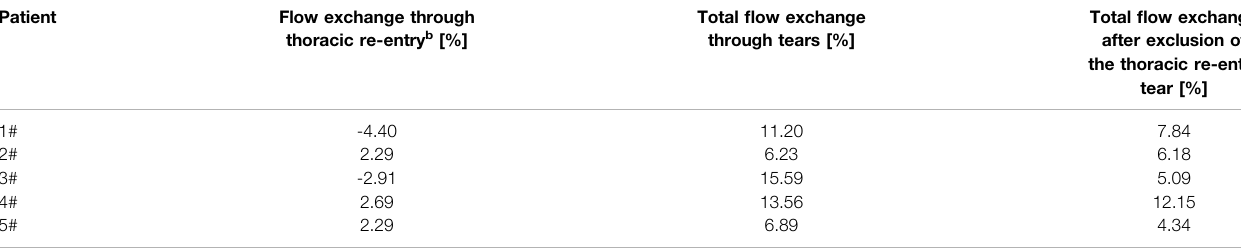
TABLE 2 | Flow exchange through the re-entry tears and the false lumen after TEVAR. a